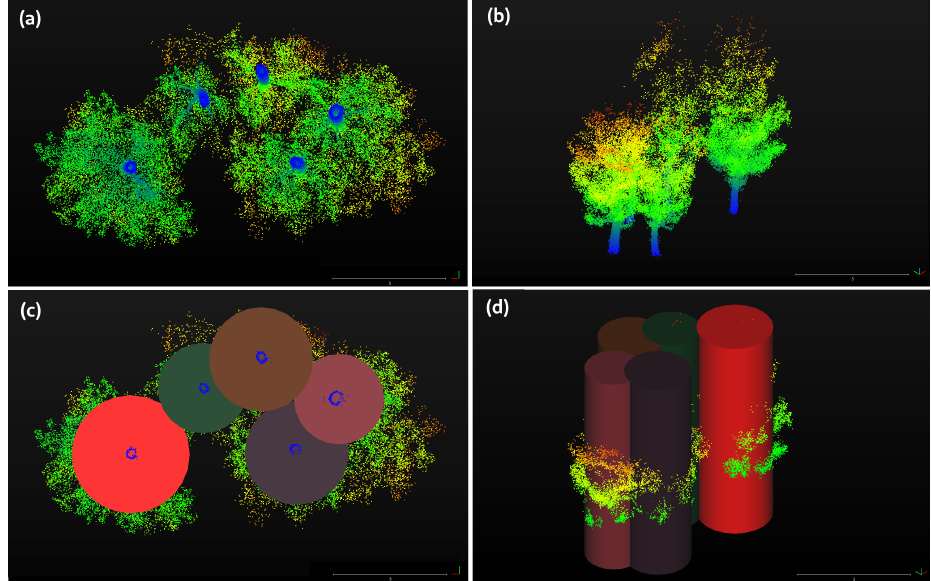
Figure 11. ( a , b ) Two point of views of some manually subtracted trees for the point cloud. ( c , d ) Cylin- der envelope of all points inside the voxelization. All points that are not inside any cylinder and, thus, discarded in the voxelization, are analyzed in the last step of the